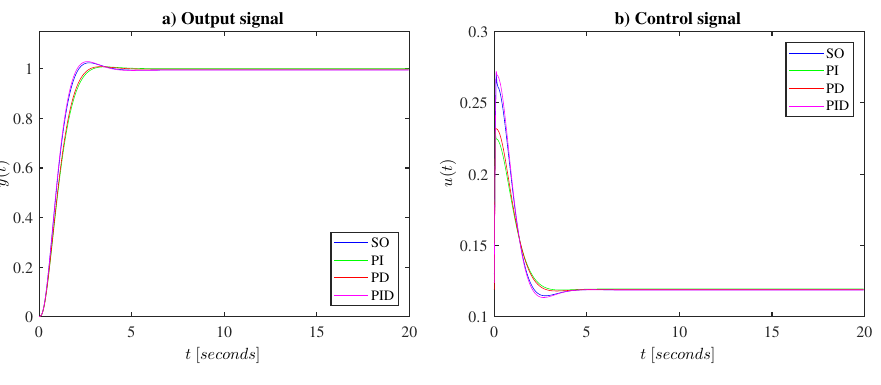
Figure 10. Results of y ( t ) and u ( t ) for case